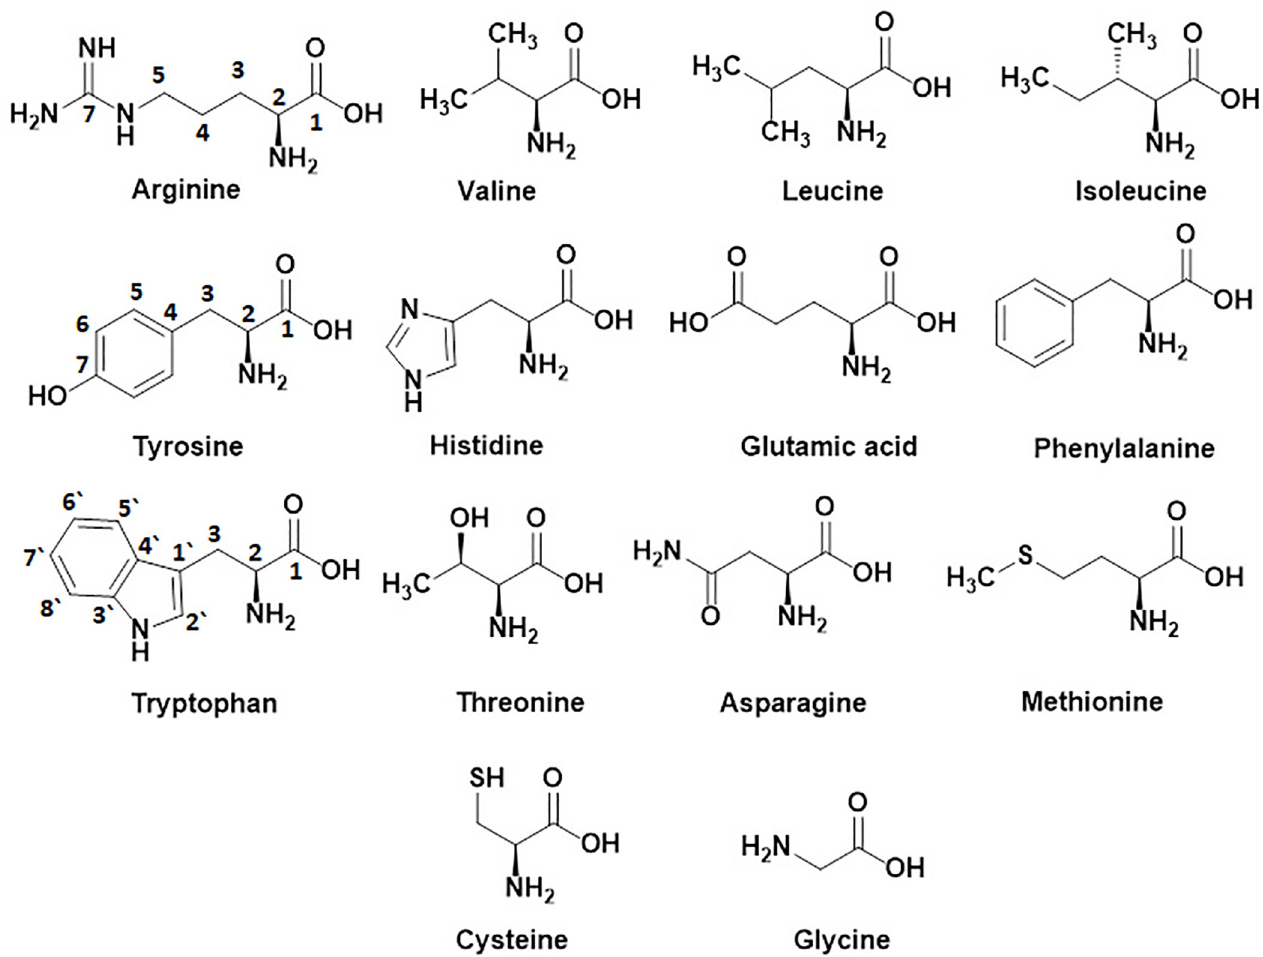
Fig 3. Chemical structures of free amino acids isolated from the deterrent water-soluble fraction of the sea lamprey skin extract: arginine, valine, leucine, isoleucine, tyrosine, histidine, glutamic acid, phenylalanine, tryptophan, threonine, asparagine, methionine, cysteine, and glycine.